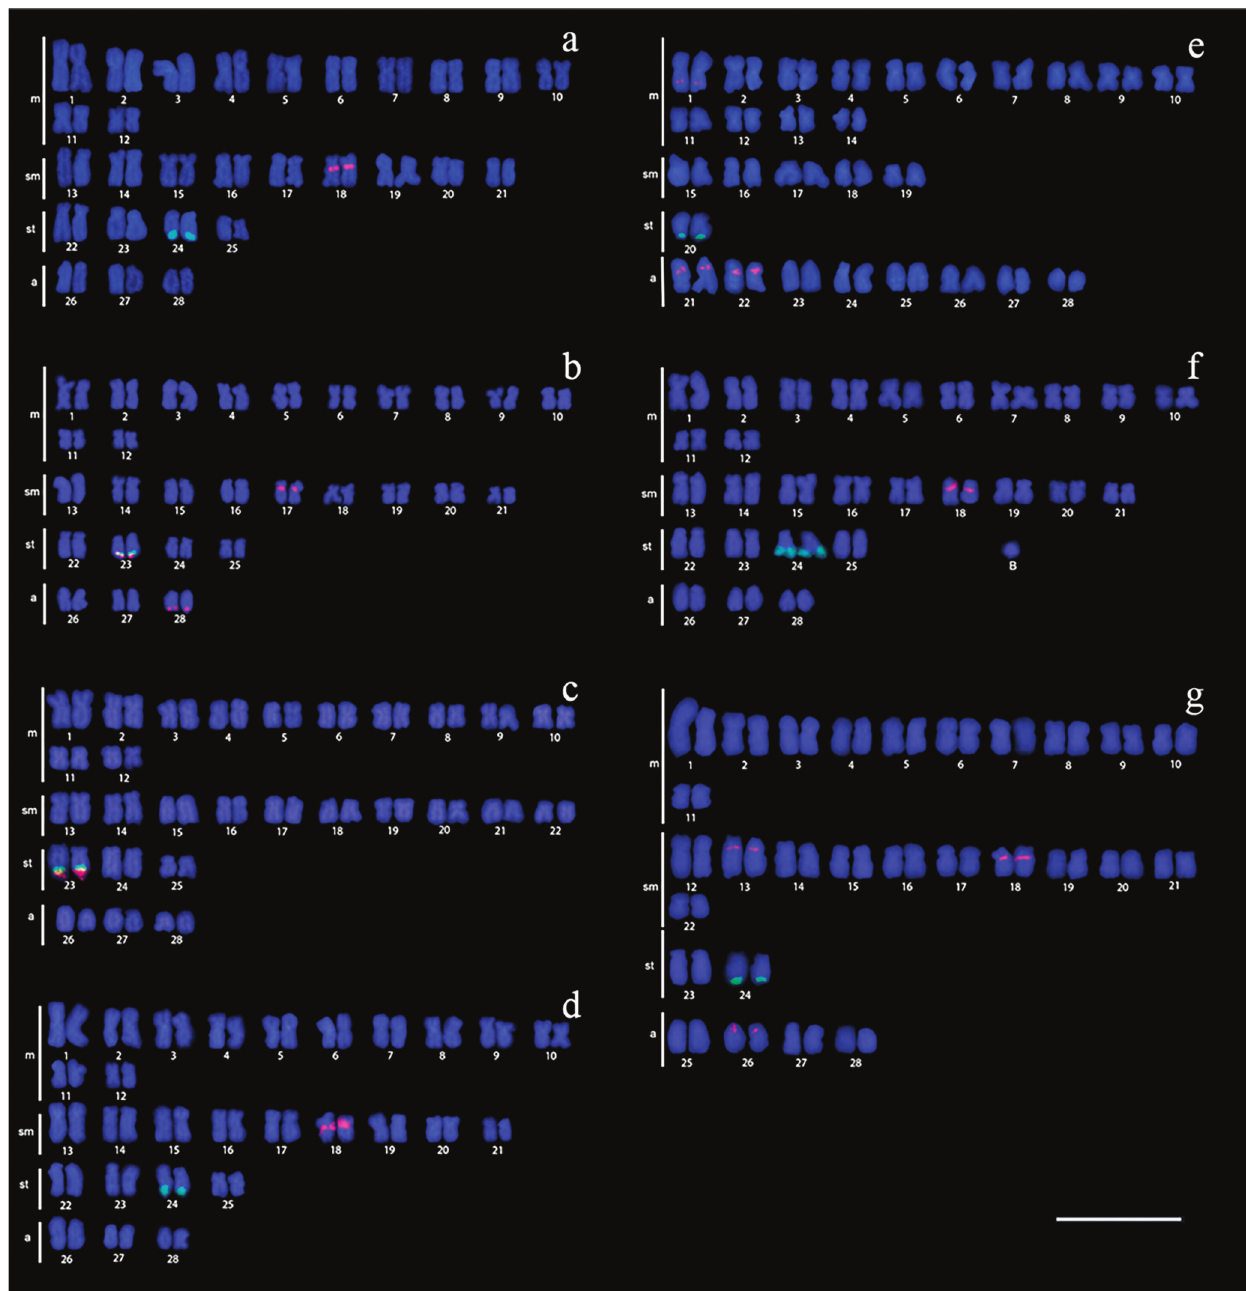
Fig. 3. Karyotypes after FISH with 5S rDNA probes (red) and 18S rDNA probe (green). a. Pimelodus absconditus ; b. Pimelodus britskii ; c. Pimelodus maculatus ; d. Pimelodus microstoma ; e. Pimelodus mysteriosus ; f. Pimelodus ortmanni ; g. Pimelodus paranaensis . Scales bar = 10